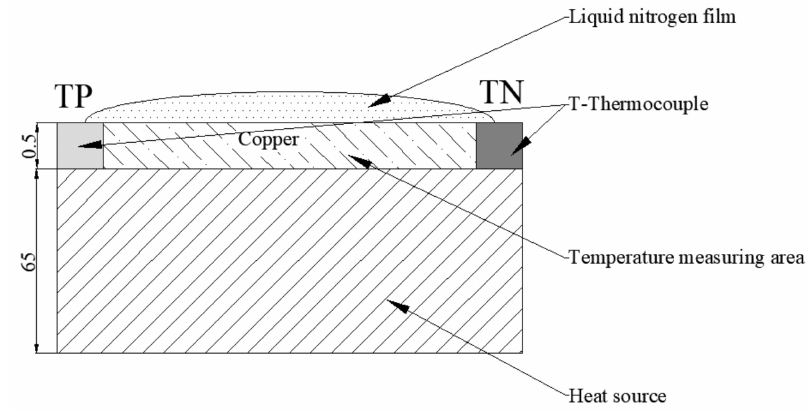
Figure 4. Schematic diagram of heat sink surface temperature